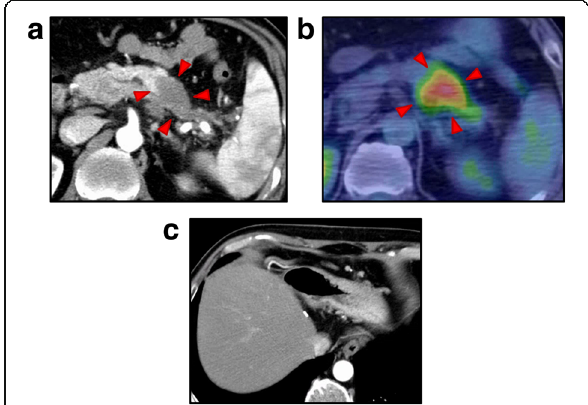
Fig. 1 Preoperative imaging of the primary pancreatic cancer. Enhanced computed tomography (CT) showed a 30-mm solid tumor in the tail of the pancreas ( a , arrowheads). Positron emission tomography – CT showed